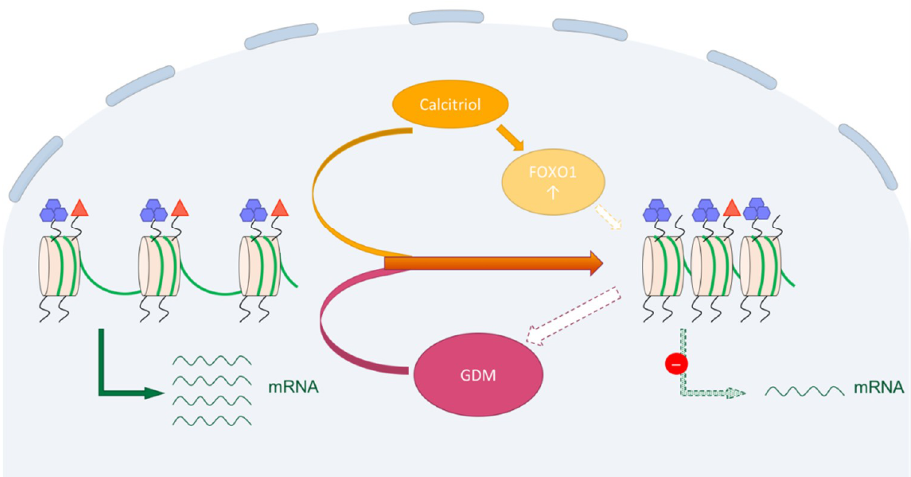
Figure 5. Two potential mechanisms leading to a reduction of H3K9ac in trophoblast cells. Immunohistochemical analysis showed a downregulation of H3K9ac (red triangle) in GDM placentas, while H3K4me3 (purple hexagons) showed no significant differences (solid pink arrow tail). The H3K9ac reduction may also be part of the aetiology of GDM (pink arrow broken line). Stimulation of trophoblast cells with calcitriol also lead to a reduction of H3K9ac, as well as an increase in FOXO1 (solid orange arrows). This may in turn be linked to the reduction of H3K9ac (yellow arrow broken line), ultimately leading to a downregulation of transcription (green arrows).